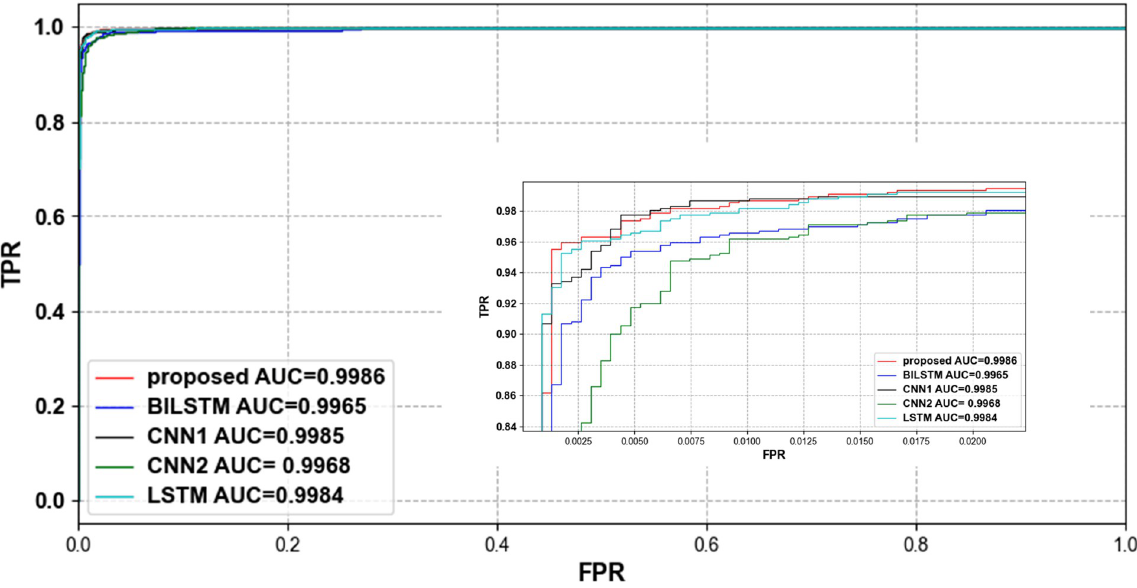
Fig 11. ROC curve of each classification model when CR = 0.05.